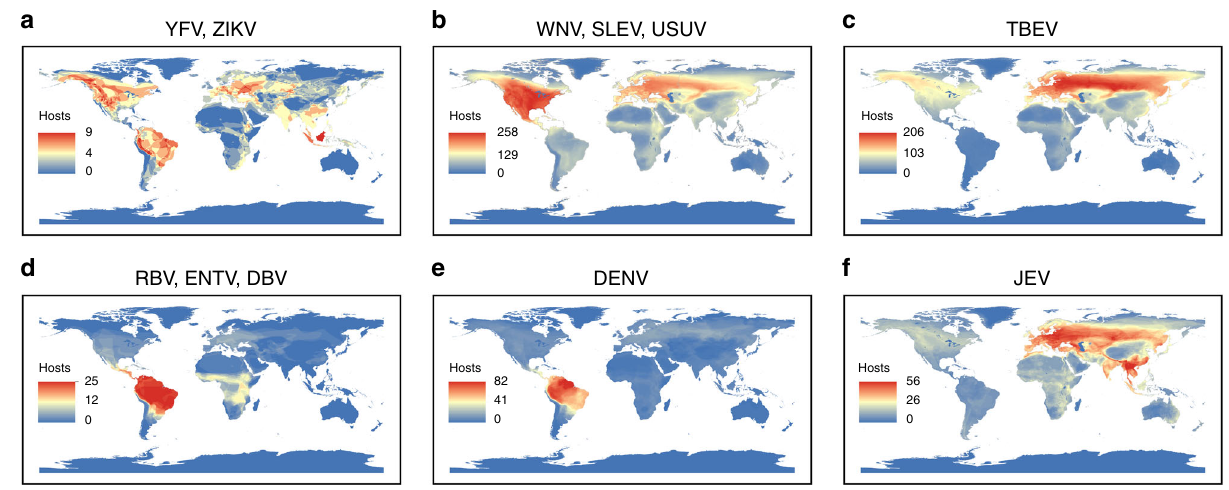
Fig. 3 Geographical distribution of predicted fl aviviral host richness. Overlapping geographical ranges of model predicted sylvatic hosts in the 95th percentile of probability for strati fi ed models. a Yellow fever virus (YFV) and Zika virus (ZIKV). b West Nile virus (WNV), St. Louis encephalitis virus (SLEV) and Usutu virus (USUV). c Tick-borne encephalitis virus (TBEV). d Rio Bravo virus (RBV), Entebbe bat virus (ENTV) and Dakar bat virus (DBV). e Dengue virus (DENV). f Japanese encephalitis virus (JEV). Maps were generated using species distribution data from IUCN 12 , and BirdLife